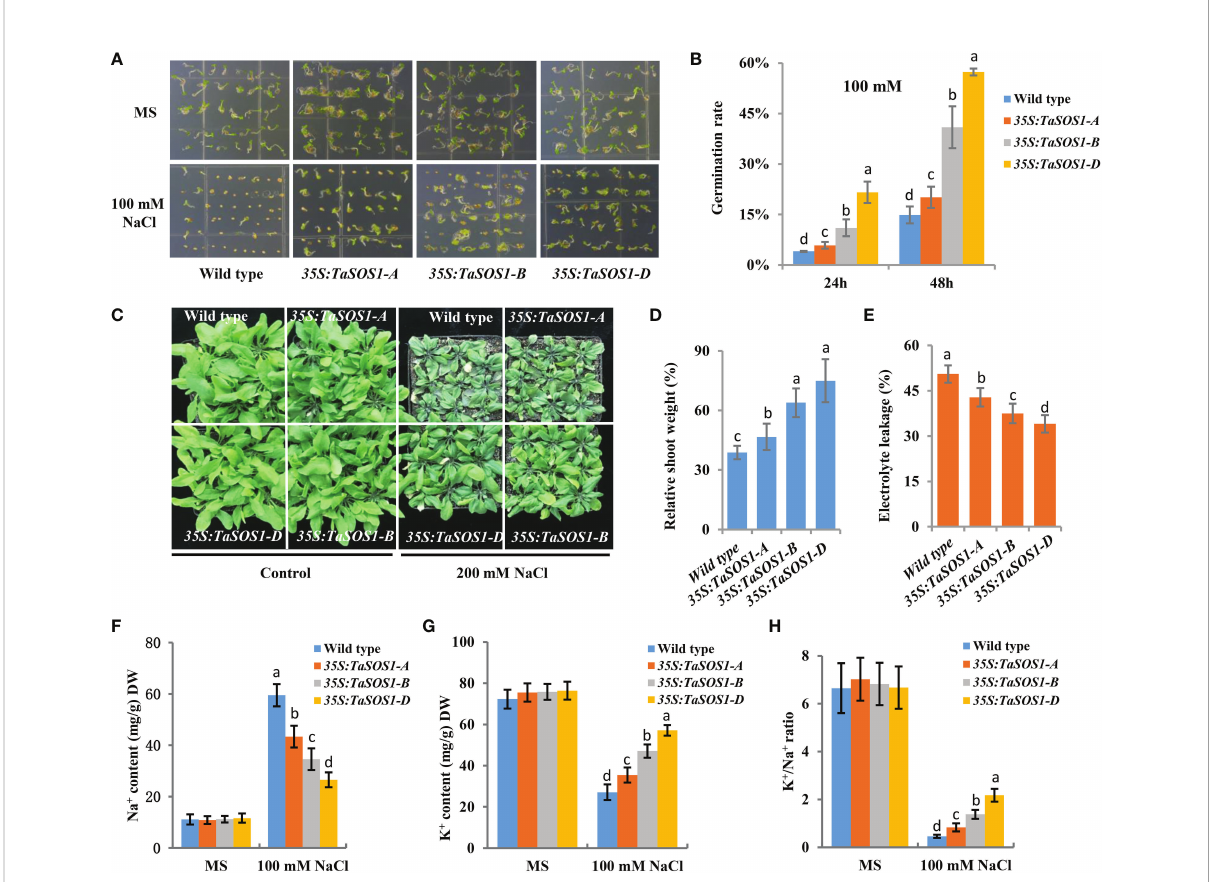
FIGURE 6 Phenotypic analysis of the 35S:TaSOS1-A, 35S:TaSOS1-B and 35S:TaSOS1-D plants exposed to salt stress. (A, B) Comparison of the seed germination of the wild type, the 35S:TaSOS1-A, 35S:TaSOS1-B and 35S:TaSOS1-D plants. Seeds harvested on the same day were planted on MS medium containing 0, or 100 mM NaCl. Plates were transferred to a growth chamber after strati fi cation at 4°C for 3 d. Photographs were taken, and germination rate was determined 24 h and 48 h after the transfer, respectively. (C, D) Comparison of seedlings growth of the wild type, the 35S:TaSOS1-A, 35S:TaSOS1-B and 35S:TaSOS1-D plants with 200 mM NaCl. Five-day-old seedlings were transferred from MS medium to soil. The plants were then irrigated under well-watered conditions (Control) or irrigated every 5 d with 200 mM NaCl solution; 15 d later, phenotypes were measured and photographed. Shoots fresh weight was measured relative to the same genotype grown on control condition. More than 30 plants were measured for each genotype. (E) Relative electrolyte leakage of leaves from wild type, 35S:TaSOS1-A, 35S:TaSOS1-B and 35S: TaSOS1-D plants after exposure to 200 mM NaCl. (F-H) Comparison of Na + contents (F) , K + contents (G) , and K + to Na + ratios (H) of leaves from 35S:TaSOS1-A, 35S:TaSOS1-B and 35S:TaSOS1-D , and wild type plants under salt stress conditions. The values are means ( ± SE) of three biological replicates. The data were analyzed by ANOVA one-way comparison followed by LSD test. Different letters above the bars indicate a signi fi cant difference at P <